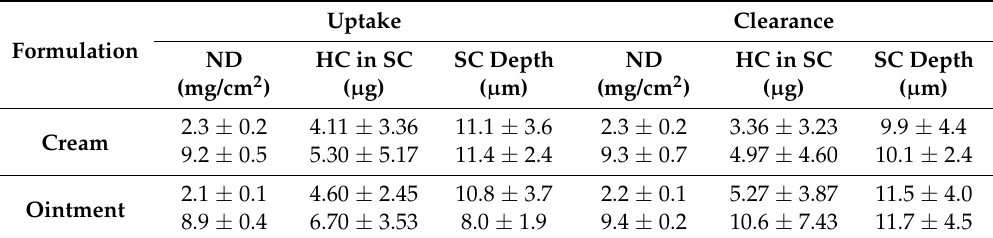
Table 2. Average ( ± SD, n = 5) normalized doses (ND) applied of cream and ointment; HC (hydrocortisone) recovery from SC (stratum corneum) and SC depth sampled for uptake and clearance samples. The area of skin tape-stripped was 3.14 cm 2